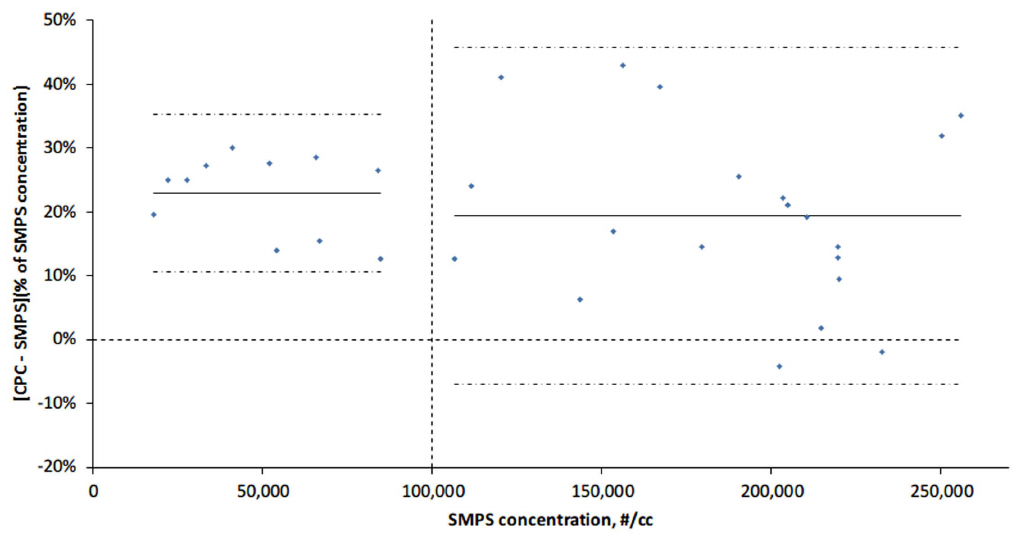
Figure 5. Result of comparing CPC with SMPS. The solid lines indicate the mean percent difference; the dashed lines indicate 6 1.96 standardized deviations (SD) around the mean percent difference; the vertical dashed line represents the CPC’s dynamic upper limit; the horizontal dashed line represents a percent difference of 0.